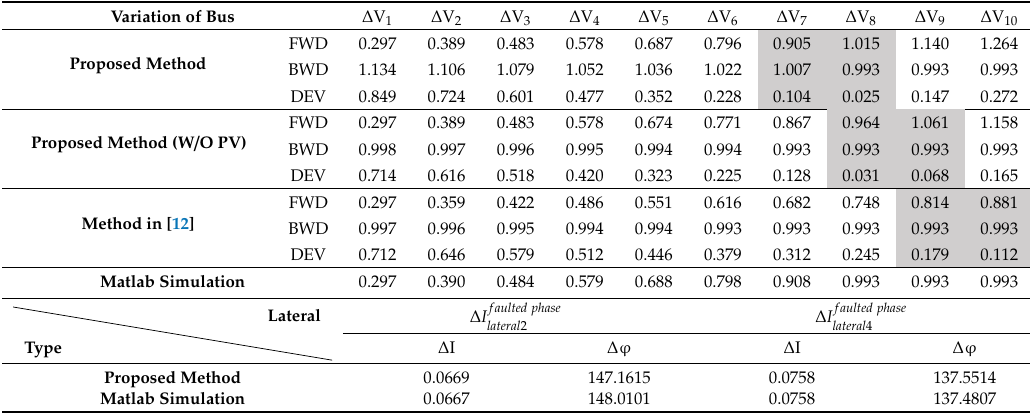
Table 4. Comparison of fault location results under a single line-to-ground